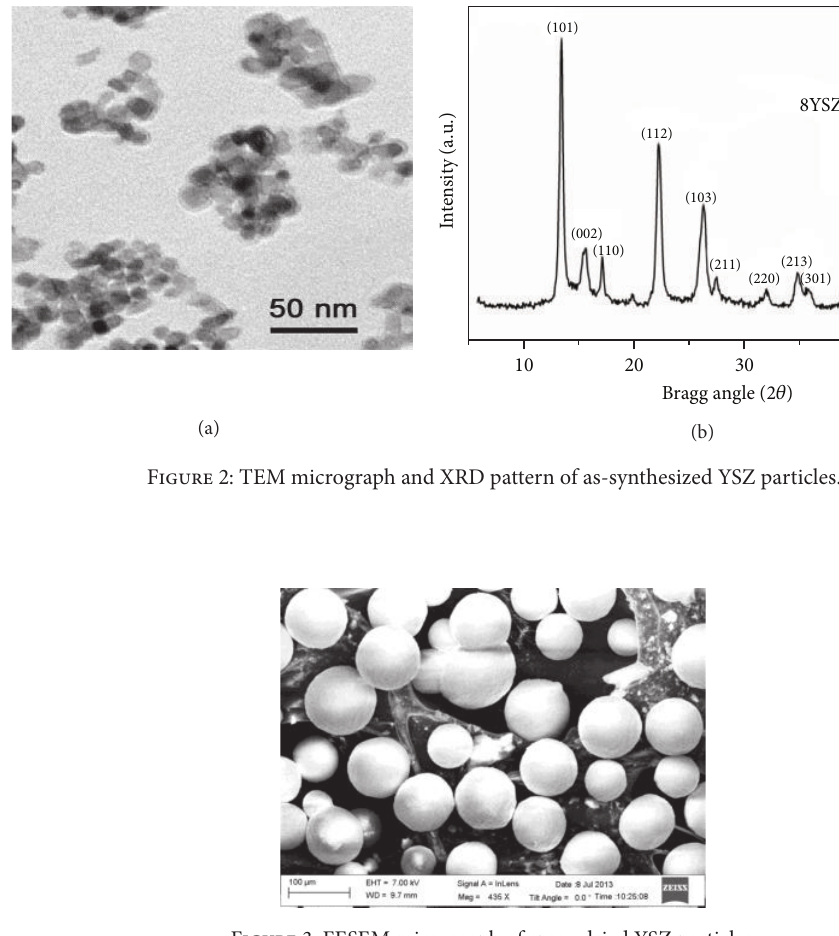
Figure 3: FESEM micrograph of spray dried YSZ particles.